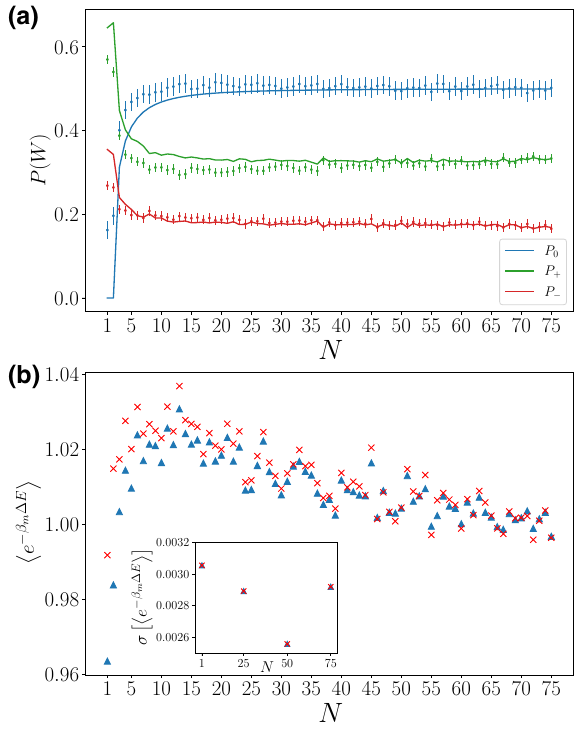
FIG. 5. (a) Work statistics with N − 1 intermediate projective measurements. (b) Robustness of the Jarzynski identity in the presence of projective measurements. The inset shows the sta- tistical uncertainty for a few values of N : N = 1, 25, 50, 75. The blue triangles refer to the ancilla-assisted method while the red crosses are obtained with the standard two-point measurement scheme.